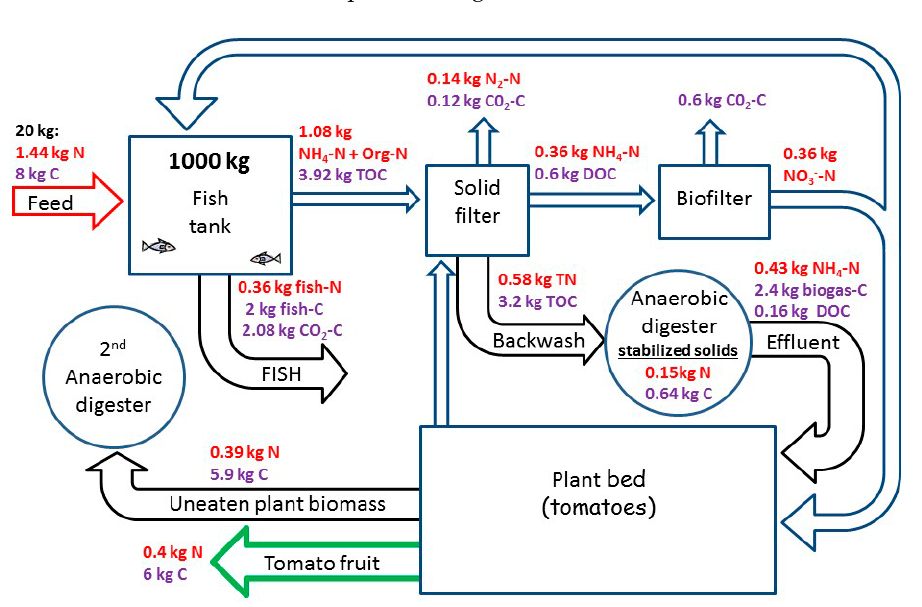
Figure 4. Predicted mass balance for carbon and nitrogen in the suggested model aquaponic system in a steady state condition. Based on the model results, 10% N is lost (mainly by passive denitrification) and the remaining 90% is recovered as fish and plant biomass.